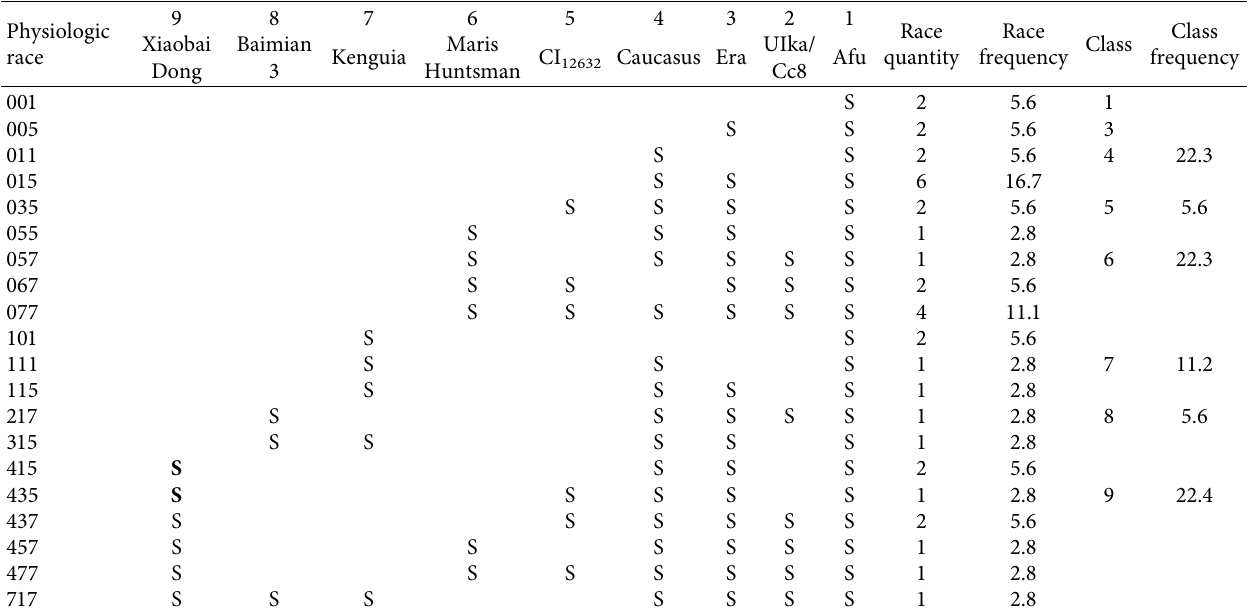
Table 1: Physiologic race identification of Blumeria graminis f.sp. tritici in central Hebei province, 2019. Physiologic